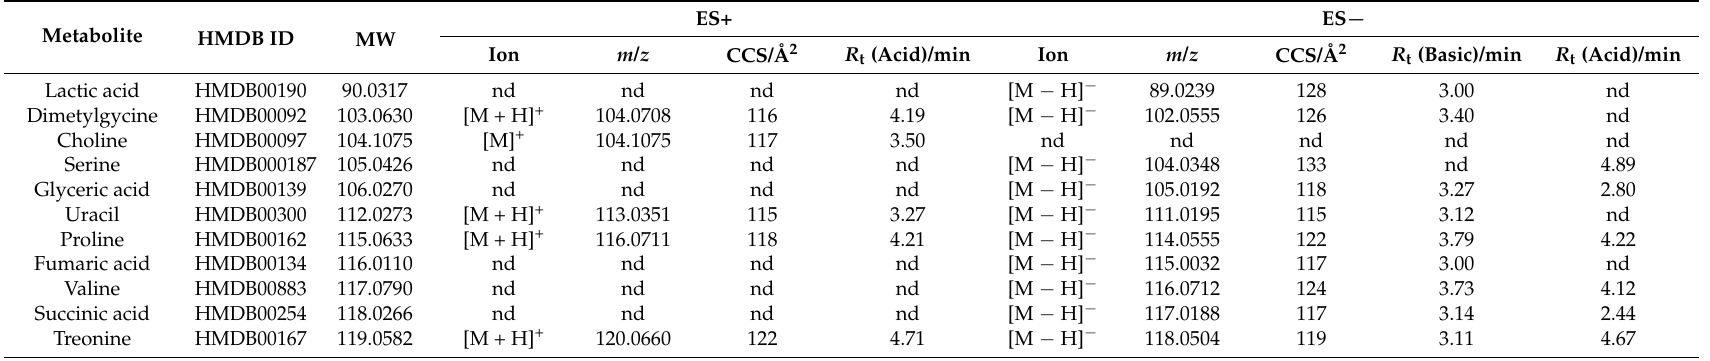
Table 5. Example of a database of polar metabolites, including R t, m / z and collision cross-section (CCS) values. Analyses were conducted using both positive ES (acidic chromatographic conditions) and negative ES (acidic and basic chromatographic conditions). Reproduced with permission from [73]. Copyright American Chemical Society, 2014.